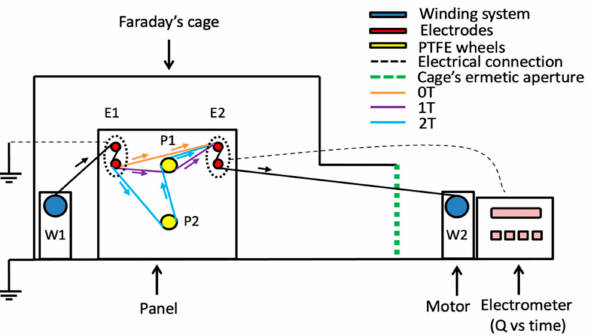
Figure 1. Schematic representation of lab-made setup for the triboelectrification of glass fibers and charge measurements tests.